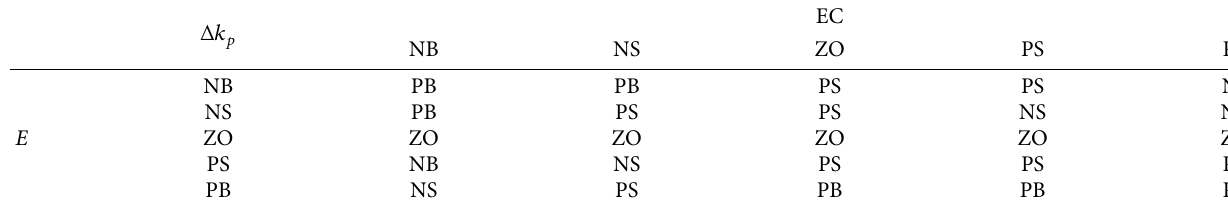
Table 2: Fuzzy rules table ∆ k